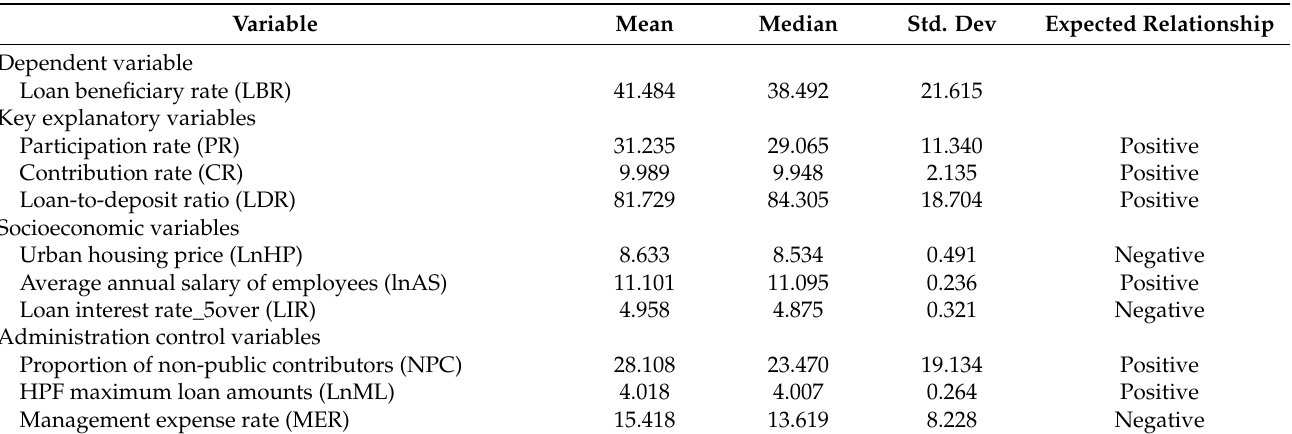
Table 1. Descriptive statistics for the variables from 2015 to